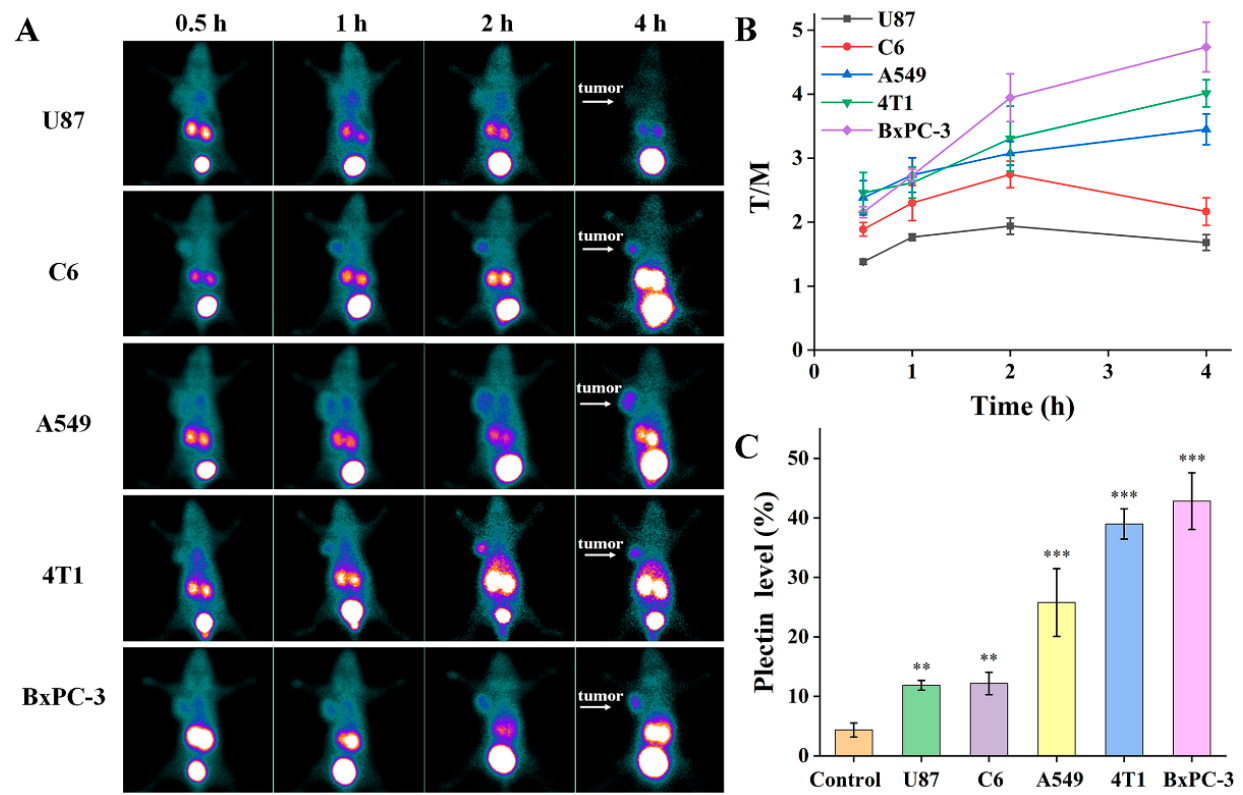
Figure 6. ( A ) SPECT images, ( B ) tumor-to-muscle (T/M) SPECT signal ratios of [ 99m Tc]Tc-HYNIC- PTP in five types of tumor-bearing mice at different time points, and ( C ) the relative plectin expres- sion levels. (**) for p < 0.01, (***) for p < 0.001.